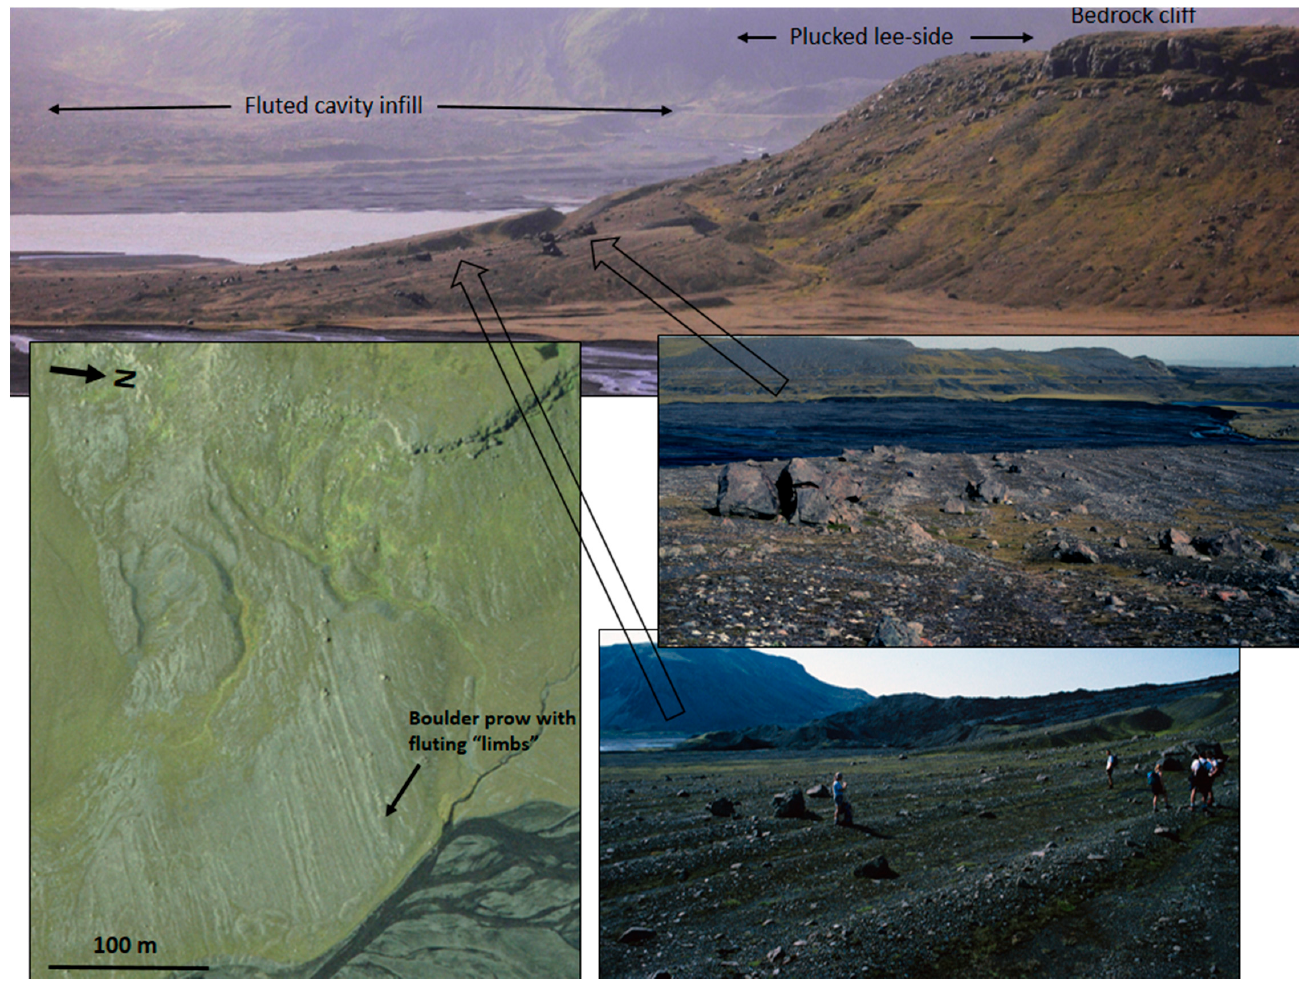
Figure 9. Aerial photograph extract (NERC ARSF 2007) and ground views of a large former subglacial cavity infill lying downflow of a bedrock cliff on the inner foreland of Sandfellsjökull. Flutings, till eskers, and angular boulders adorn the surface of the cavity infill (see Evans et al., [26]).